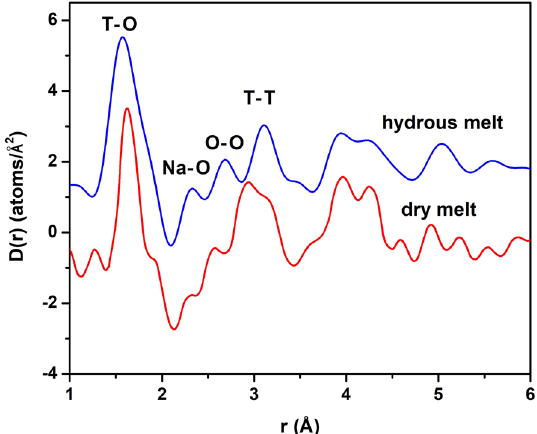
Figure 2. The total differential distribution function D(r) for the hydrous albite melt at 800 °C and approximately 0.3 GPa (blue line) and for the dry albite melt measured by Yamada et al. 25 at 1500 °C and 5.3 GPa (red